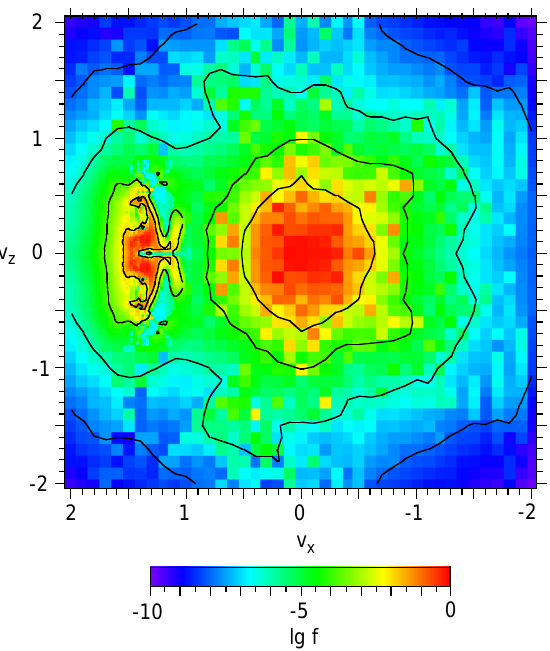
Fig. 6. Phase space density in the v x ,v z plane at x =− 10 ,y = 5 ,z = 0 and t = 9min. The f values are calculated using initial kappa distri- butions (see text). The black contours represent levels of constant f for a slightly smoothed distribution.